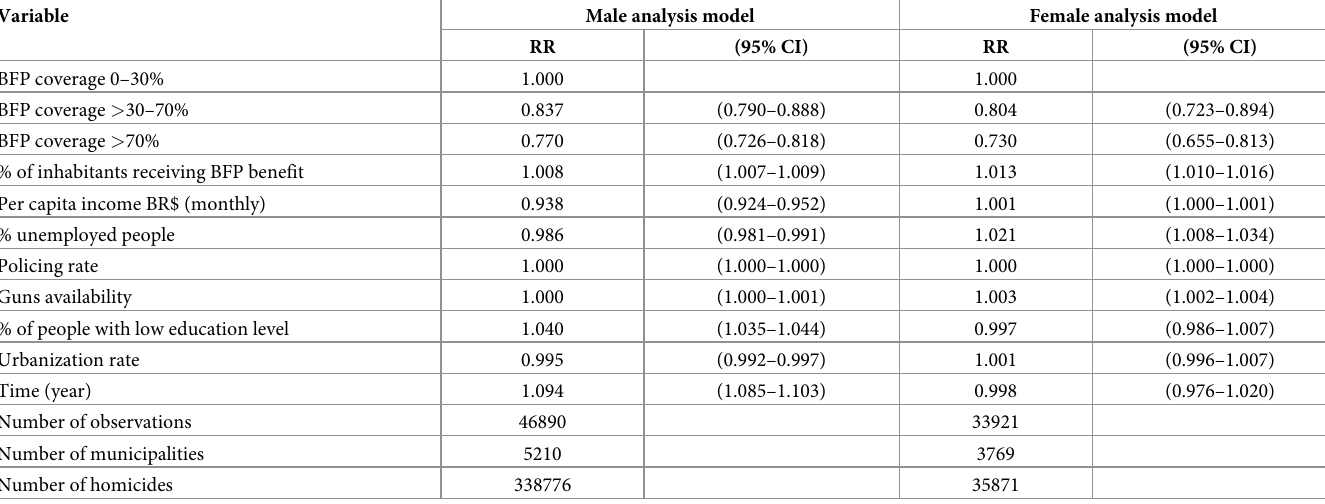
Table 4. Fixed effect regression models for adjusted associations between homicide rates and BFP coverage in the Brazilian municipalities by gender, 2004–2012.